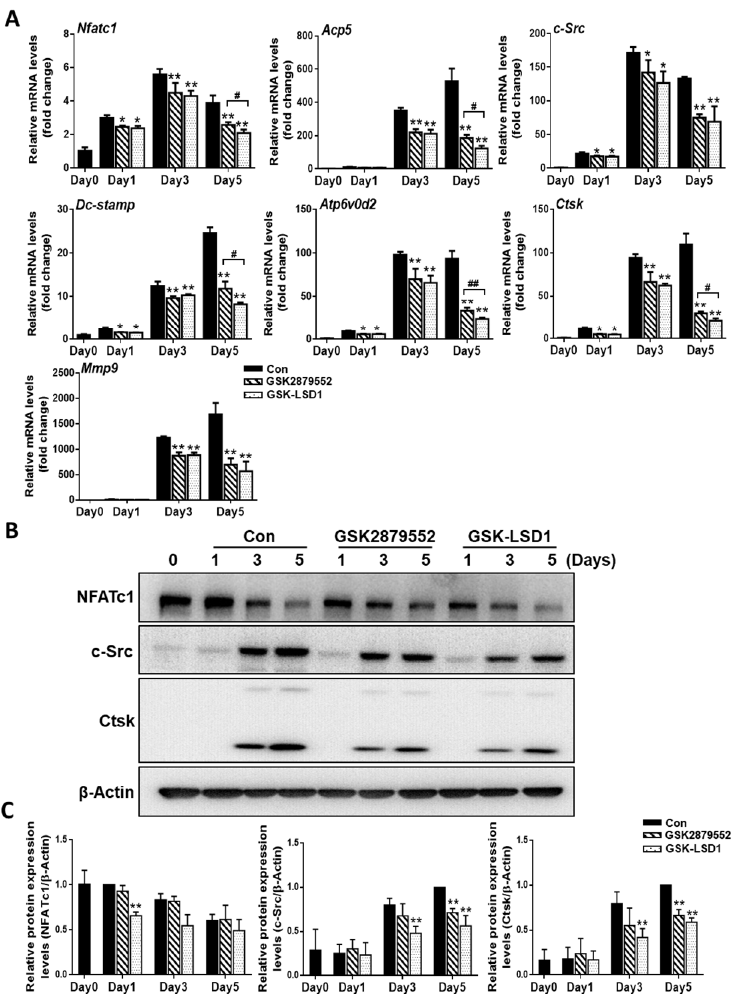
Figure 4. LSD1 inhibitors decrease the expression of osteoclast-specific genes and proteins. BMMs were cultured with or without LSD1 inhibitors for 1, 3, and 5 days. ( A ) The mRNA expression of osteoclast-related genes was analyzed by qRT-PCR. The mRNA was standardized to GAPDH control. The data presented are the mean ± SD of three independent experiments. * p < 0.05; ** p < 0.01, LSD1 inhibitors treatment group compared with the control group. # p < 0.05; ## p < 0.01, the GSK2879552 treatment group compared with the GSK-LSD1 treatment group. ( B ) Western blotting analysis was performed to indicate the expression of osteoclast-specific proteins. * p < 0.05; ** p < 0.01, LSD1 inhibitors treatment group compared with the control group. ( C ) The protein levels of NFATc1, c-Src, and Ctsk were calculated by image J, and normalized to β